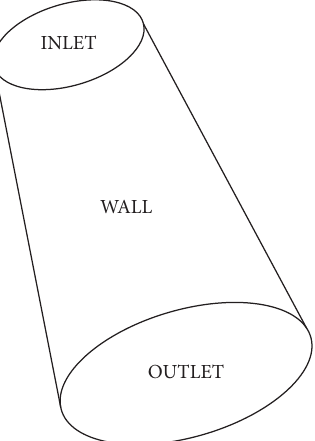
Figure 4: Computational domain of aircraft wake vortex field.